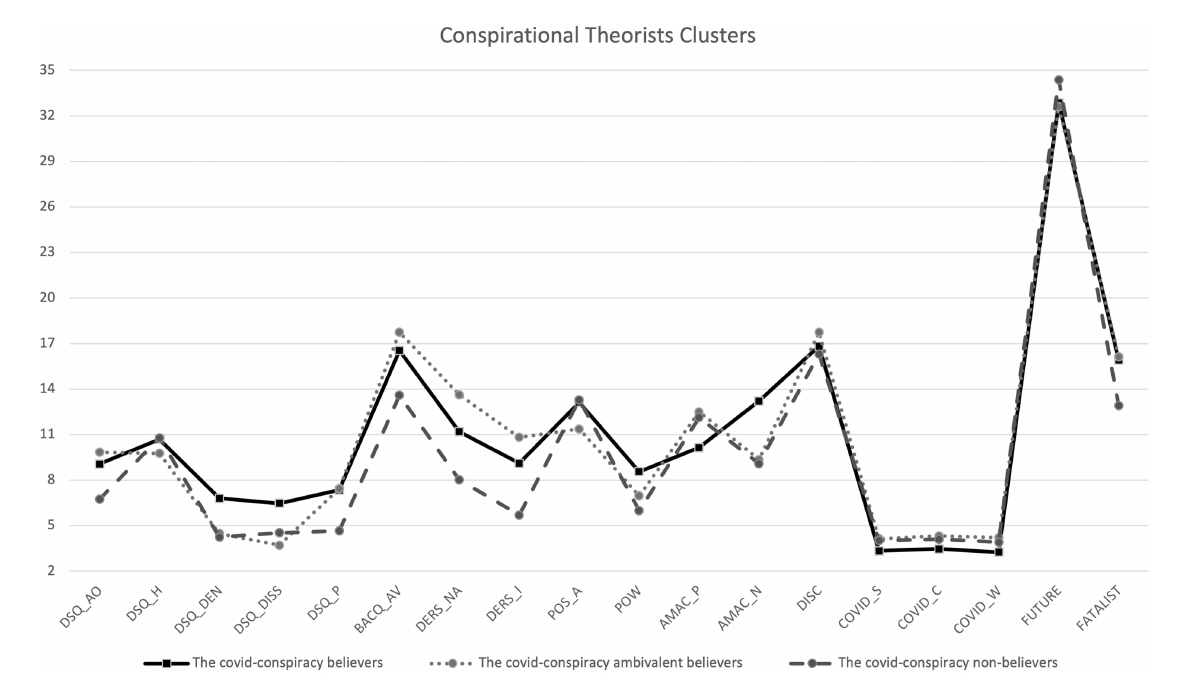
FIGURE1 Graphical Representation of Clusters. DSQ_AO, Acting Out subscale of DSQ; DSQ_H, Humor subscale of DSQ; DSQ_DEN, Denial subscale of DSQ; DSQ_DISS, Dissociation subscale of DSQ; DSQ_P, Projection subscale of DSQ; BACQ_AV, Avoidance subscale of BACQ; DERS_NA, Non-Acceptance subscale of DERS-20; DERS_I, Impulse subscale of DERS-20; POS_A, Positive Affect subscale of PANAS; POW, Powerlessness; AMAC_P, Positive Attitudes and Mood toward Coronavirus; AMAC_N, Negative Attitudes and Mood toward Coronavirus; DISC, Discontent for COVID-19; COVID_S, Beliefs toward Coronavirus Severity; COVID_ C, Beliefs toward Coronavirus Contagiousness; COVID_ W, Worrying for Coronavirus; FUTURE, Future subscale of STPI; FATALIST, Fatalistic Present subscale of